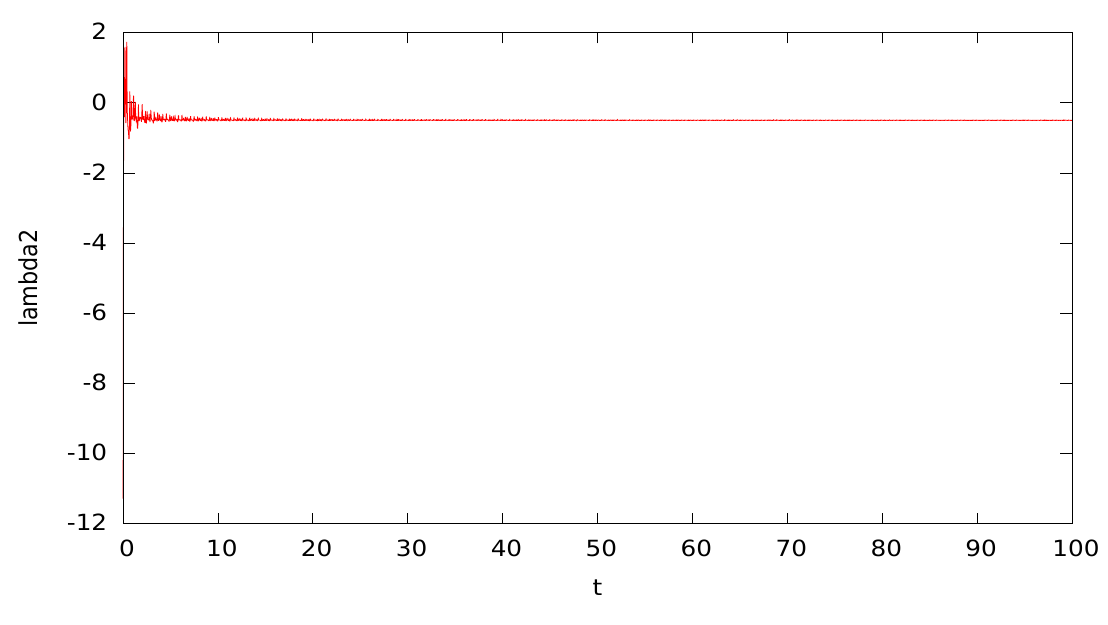
Figure 4. The graph of the change in time of the Lyapunov exponent LE 2 .